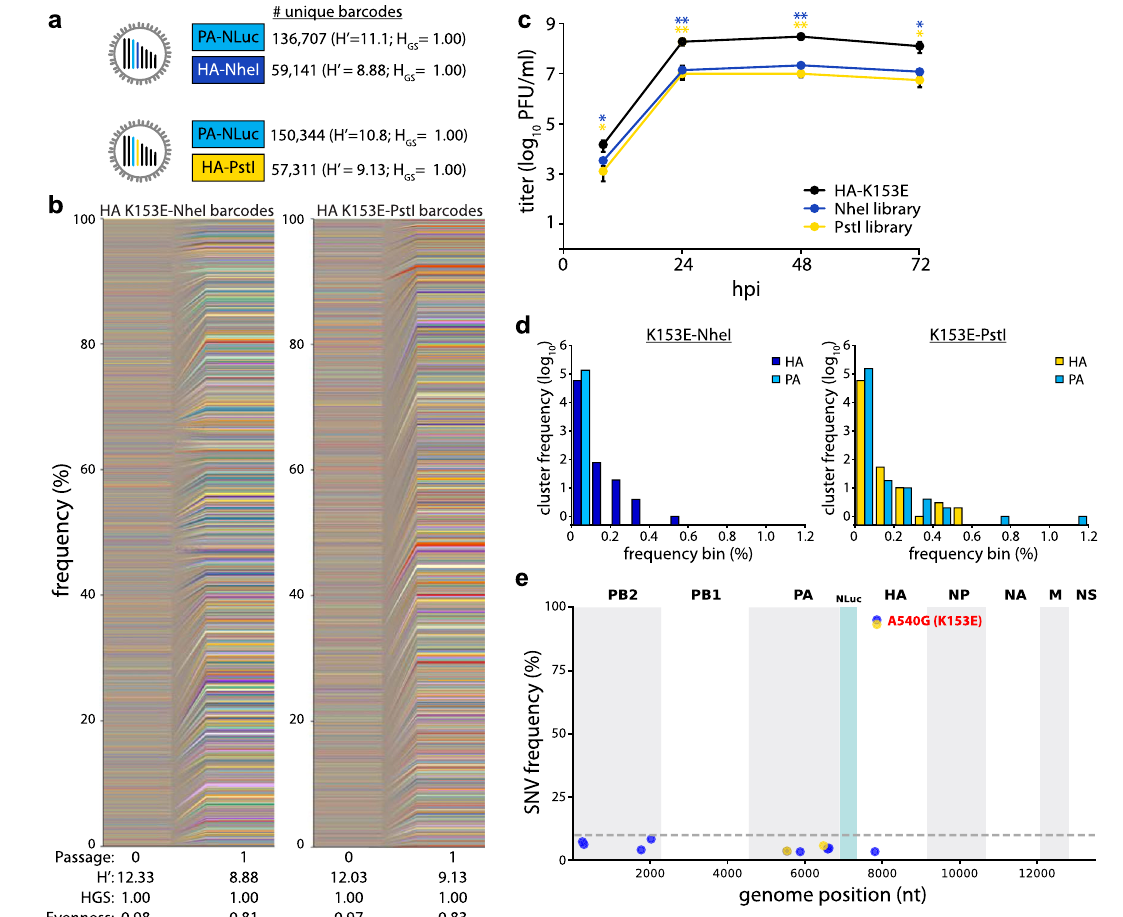
Fig. 3 Generation of large and evenly distributed dual-barcoded virus libraries. a , b Properties of the A/CA/07/2009 HA-K153E PASTN virus libraries. Data are from a single sequencing replicate; see Supplemental Figs. 1, 2 for additional analyses. c Multistep growth curves of dual-barcoded PASTN libraries compared to the parental strain A/CA/07/2009 HA-K153E. Viral titer was measured by plaque assay (mean of n = 3 ± sd, two-way ANOVA with Tukey ’ s post hoc, * p < 0.05 and ** p < 0.01 compared to the parental). d Frequency distribution of unique barcodes on HA and PA binned in 0.1% increments. e Whole-genome sequencing was performed on ampli fi ed viral stocks and SNV frequencies are indicated at each nucleotide position for each library. Source data are provided as a Source Data fi